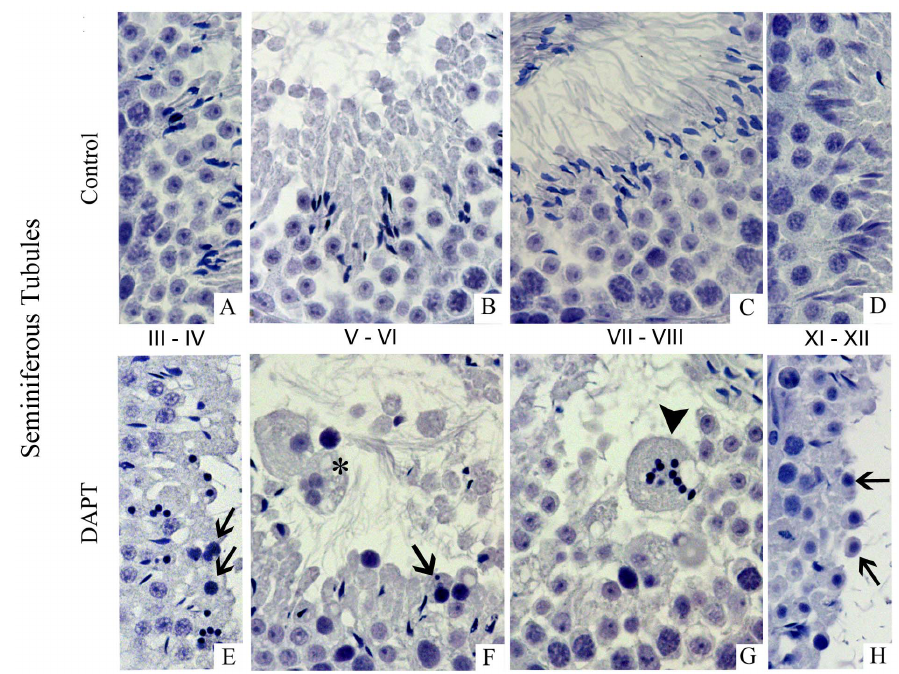
Figure 4. DAPT treatment induces formation of abnormal germ cells. Haematoxylin staining (400x magnification). Arrows mark spermatids that fail to elongate. Arrow heads mark germ cells with several small nucleus/nuclear fragments. Asterisk marks giant multinucleated germ cell. Seminiferous tubules from control mice (A–D). Elongating spermatids appear with several round small nuclei (E, H). Giant multinucleated germ cells (F). Enlarged germ cells with vacuolated cytoplasm and several nuclear fragments (G). Round spermatids fail to elongate, become round, pyknotic, and are released in the lumen (F, H).